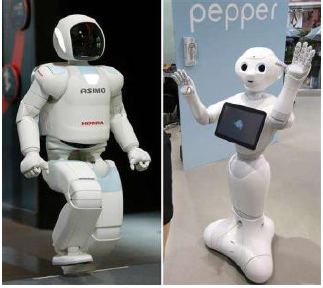
Figure 1. The Honda Asimo robot ( left ) and the Softbank Robotics Pepper robot ( right ), both are examples of humanoid robots aimed at close interaction with people [3].